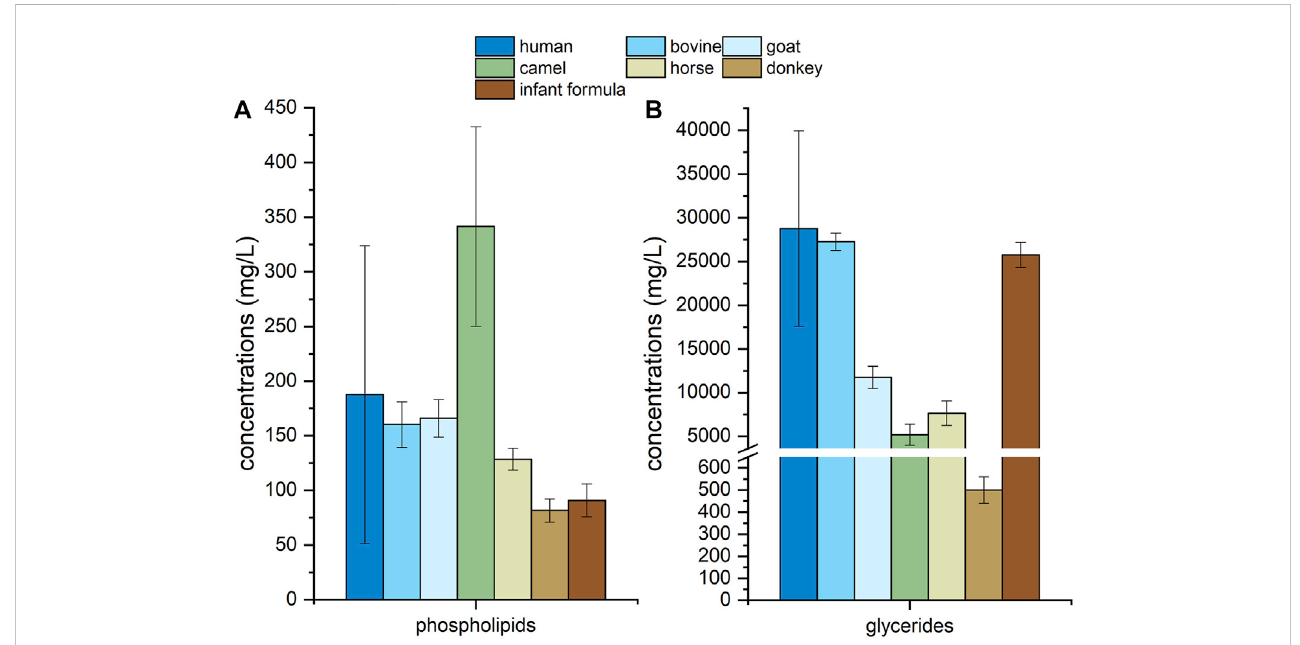
FIGURE 6 Concentrations of phospholipids (A) and glycerides (B) in human milk, mammalian milk and infant